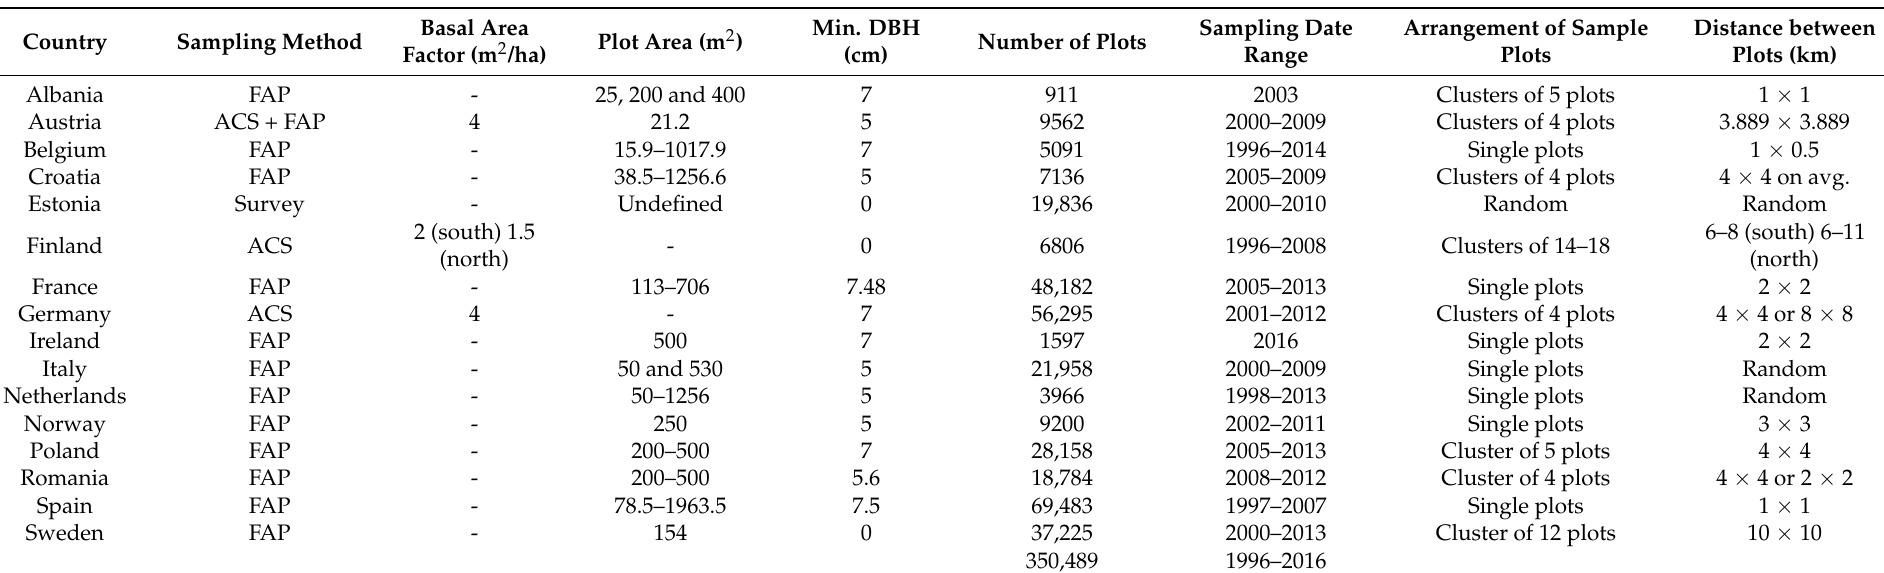
Table 1. Summary of the 16 used National Forest Inventory (NFI) datasets. Fixed Area Plots (FAP) and Angle Count Sampling (ACS) [43]. For ACS we provide the basal area factor, while for FAP we show plot area. Min. DBH is the minimum diameter at breast height (DBH) required for each tree to be included in the sample. Sampling Date Range provide information about the observation period by country. Arrangement of sample plots indicates whether the inventory plots are arranged as single plots or within